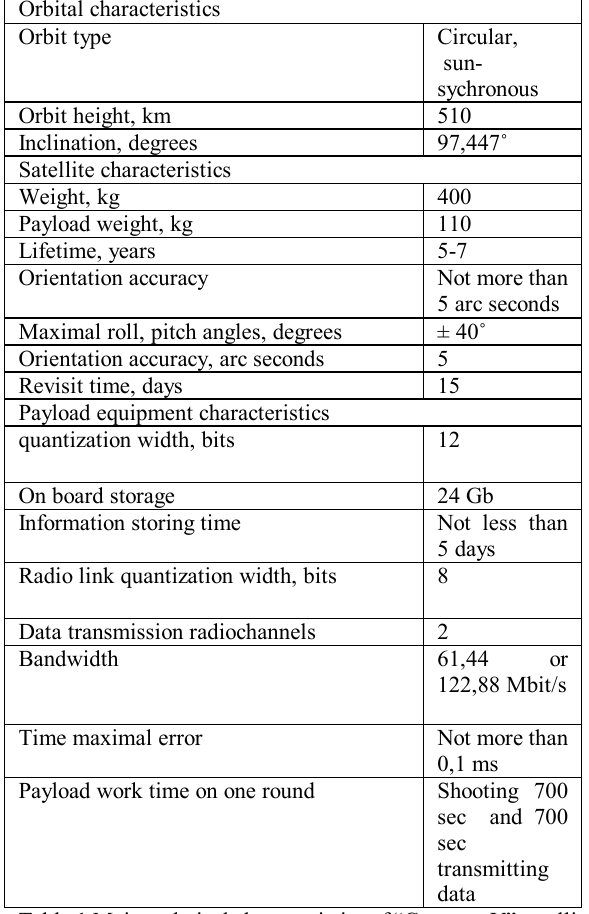
Table 1 Main technical characteristics of “Canopus-V” satellite. Shooting scheme is shown on figure 2.